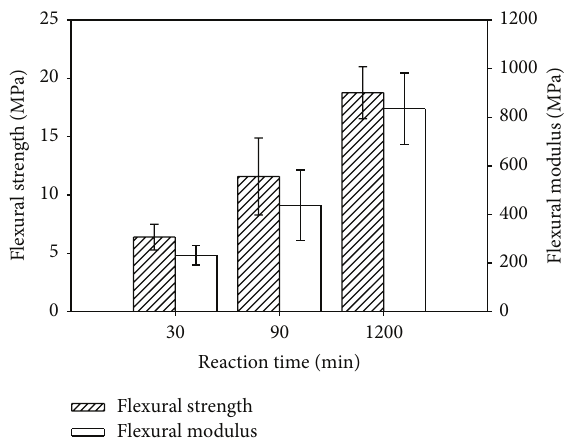
Figure 1: Effect of varying the incubation times using EMIMAc IL on the flexural properties of LCs. All LCs were subjected to a 60 ∘ C incubation temperature and soaked in water for 4 hrs.